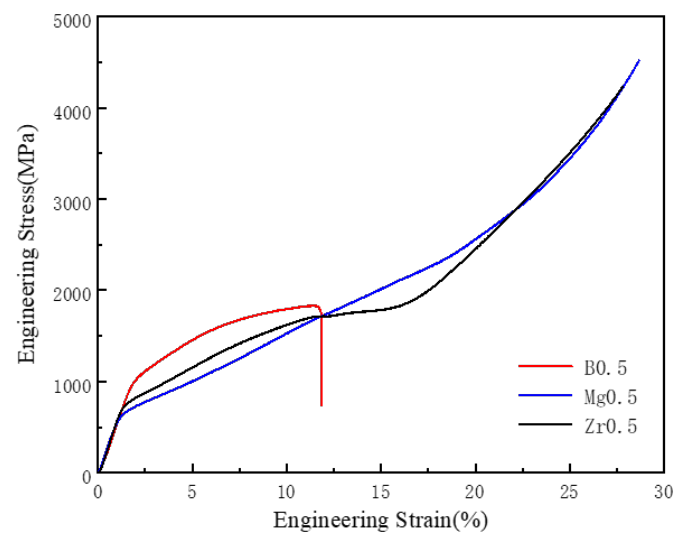
Figure 7. Compressive stress-strain curves of the B0.5, Mg0.5, and Zr0.5 HEAs. The average values of the elastic modulus of each alloy obtained by room tempera- ture compression experiment are 57.31 GPa (B0.5), 42.40 GPa (Mg0.5), and 53.10 GPa (Zr0.5), respectively. The results show that the alloys with B have higher elastic modulus than those with Mg or Zr. Compared with B doped alloy, the addition of Zr or Mg reduces the elastic modulus of the alloy, thus reducing the stiffness of the material. As illustrated in Figures 2 and 3, the highest fraction of the BCC phase in B0.5 HEA is the main factor responsible for its low compressive strain and the high compressive yield strength. In contrast, the Mg0.5 and Zr0.5 HEAs have better plasticity because the FCC/L1 2 structure has more slip systems and the grains are better able to coordinate de- formation during the plastic deformation. Solid solution strengthening and precipitation strengthening are the main strengthening mechanisms of the alloys. The integration of solute atoms with different atomic sizes into the solid solution causes lattice distortion. Since the atomic sizes of the added Mg and Zr are much larger, the lattice distortion en- ergy increases significantly and the solid solution strengthening is enhanced after the at- oms enter the crystalline lattice, which also plays a certain role in improving the strength of the alloy. Combined with the microstructure analysis of the alloy, it is evident that the size and volume fraction of the precipitate particles of the alloy doped with different trace elements are different. The L1 2 precipitates have a co-lattice relationship with the FCC matrix. The increase in the particle size and volume fraction of L1 2 precipitates enhances the hindrance effect on the dislocation movement, which leads to an increase in the strength of the alloy. Since the BCC precipitates and the FCC matrix belong to the non-